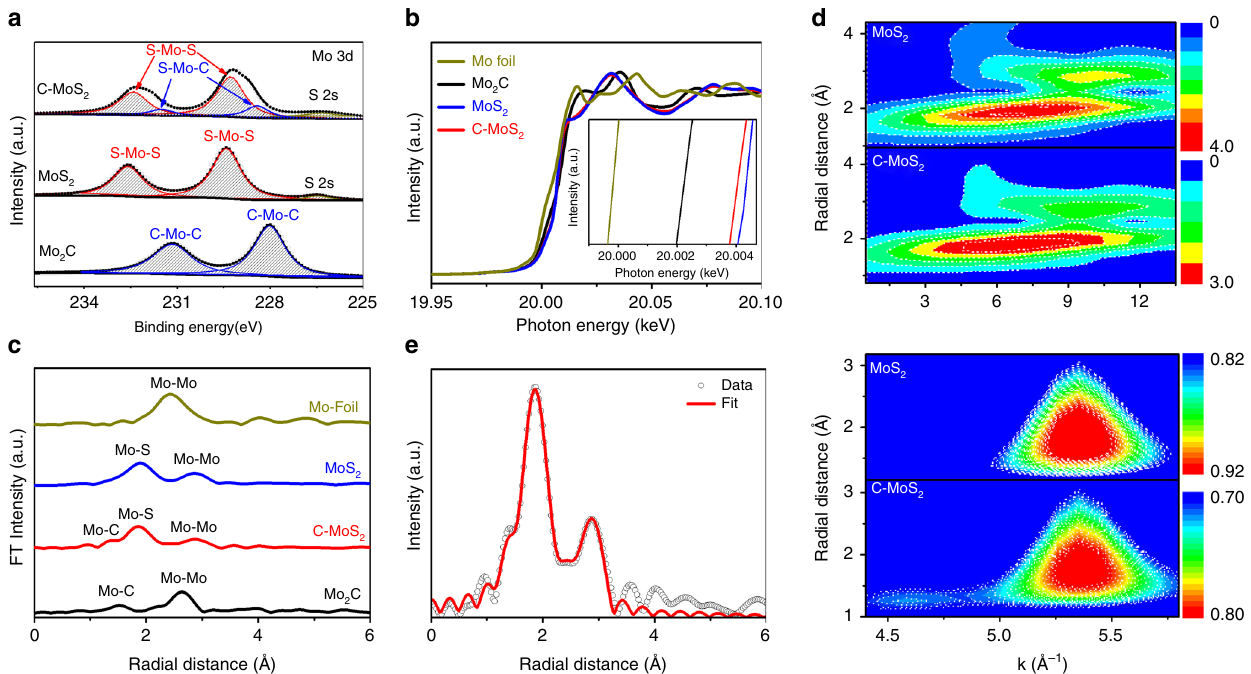
Fig. 3 Chemical states and coordination structures of C – MoS 2 . a XPS core-level Mo 3d spectra of Mo 2 C, MoS 2 , and C – MoS 2 , respectively. b The normalized Mo K-edge XANES spectra. Inset: the enlarged Mo K-edge XANES spectra. c Fourier transform (FT) of Mo K-edge of Mo 2 C, C – MoS 2 , MoS 2 , and Mo foil. d The whole contour plots of wavelet transform (WT) of MoS 2 and C – MoS 2 (upper) and the more-re fi ned fi rst shell analysis (lower). e Radial distribution of Fourier-transformed EXAFS signal of C – MoS